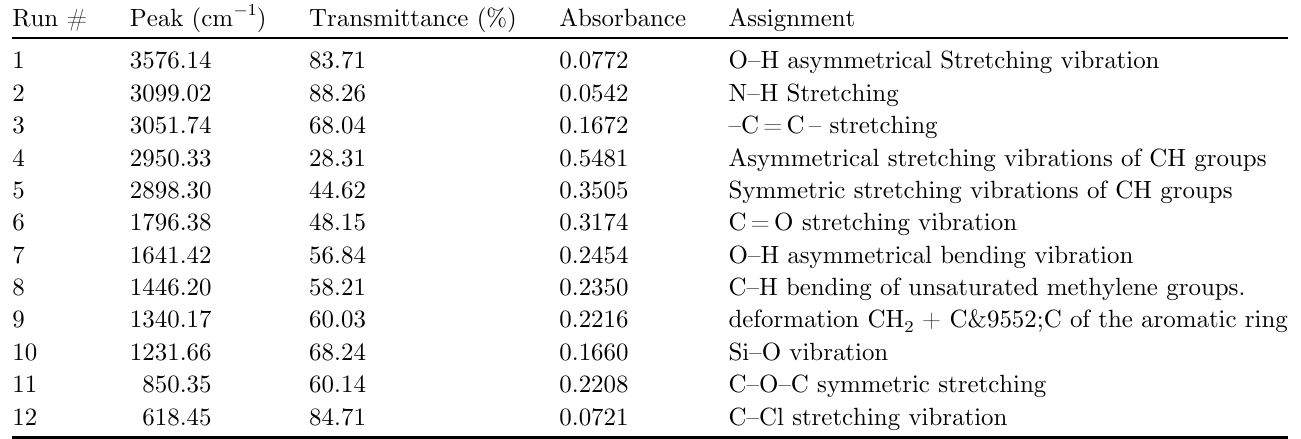
Table 4. FTIR spectra values for dolomite fi lled polyurethane foam.